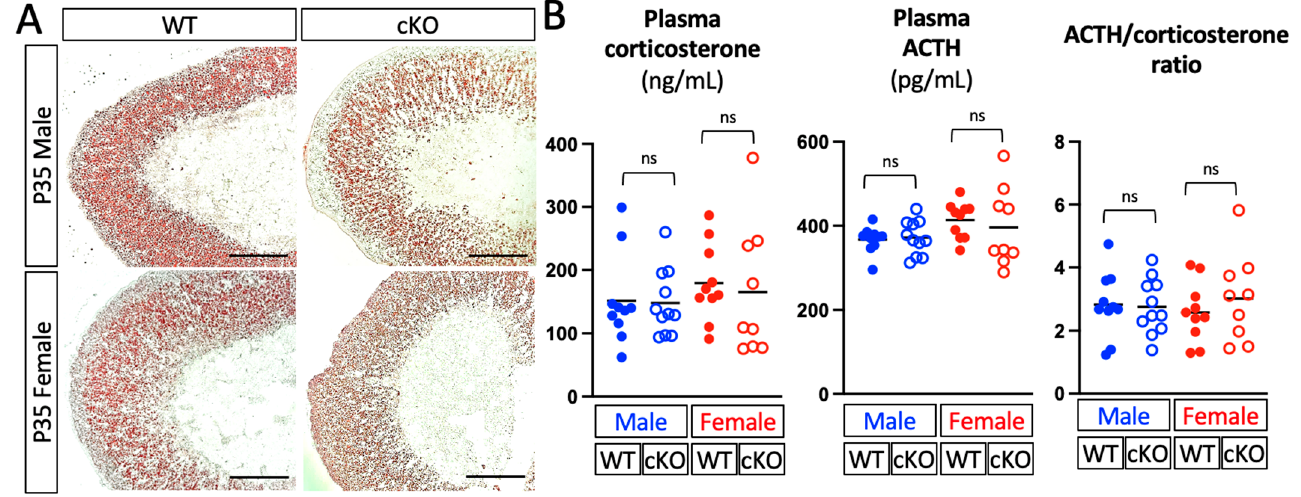
Figure 6. Phenotypic analyses of Dhcr24 cKO mice. ( A ) Oil Red O staining showing lipid droplets in the adrenal glands of euthyroid P35 mice. ( B ) Plasma levels of corticosterone, ACTH, and the ACTH/corticosterone ratio in euthyroid P35 mice. Each dot (WT) and circle (cKO) represents data from one mouse. Data are shown with the mean. Scale bars, 210 µm. WT: wild-type mice, cKO: Dhcr24 conditional knockout mice. ns, no significant difference.